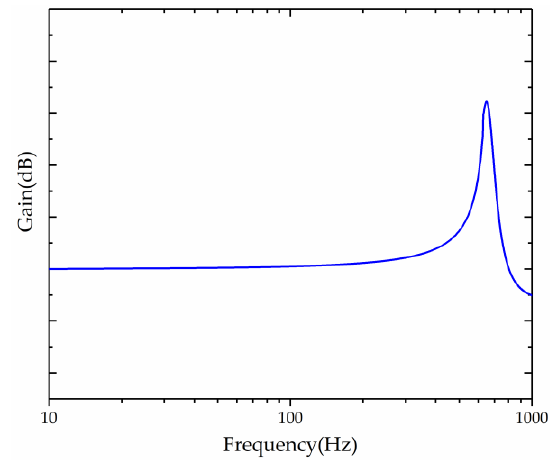
Figure 5. The typical transfer function shape of CVH or FUVH.